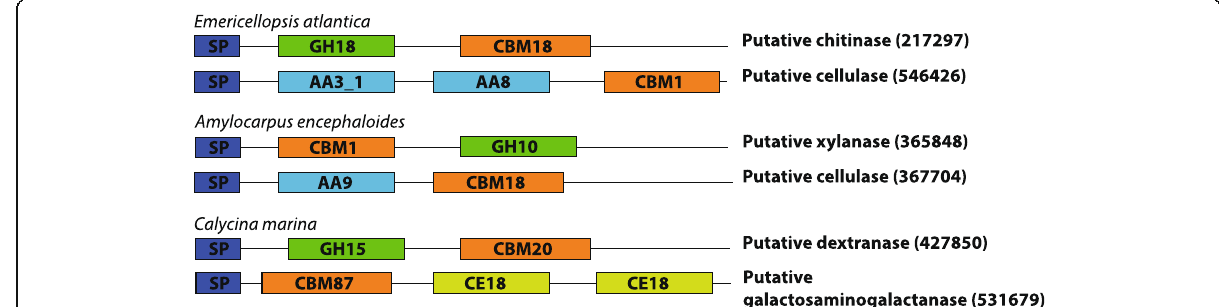
Fig. 4 Examples of putatively secreted modular CAZymes from Emericellopsis sp. TS7, Amylocarpus encephaloides and Calycina marina . The illustration is not to scale. SP – Secretion signal peptide, GH – Glycoside hydrolase, CBM – Carbohydrate binding module, AA – Auxiliary activity, CE – Carboxyl esterase. Number indicates enzyme class. Number in brackets is protein identifier